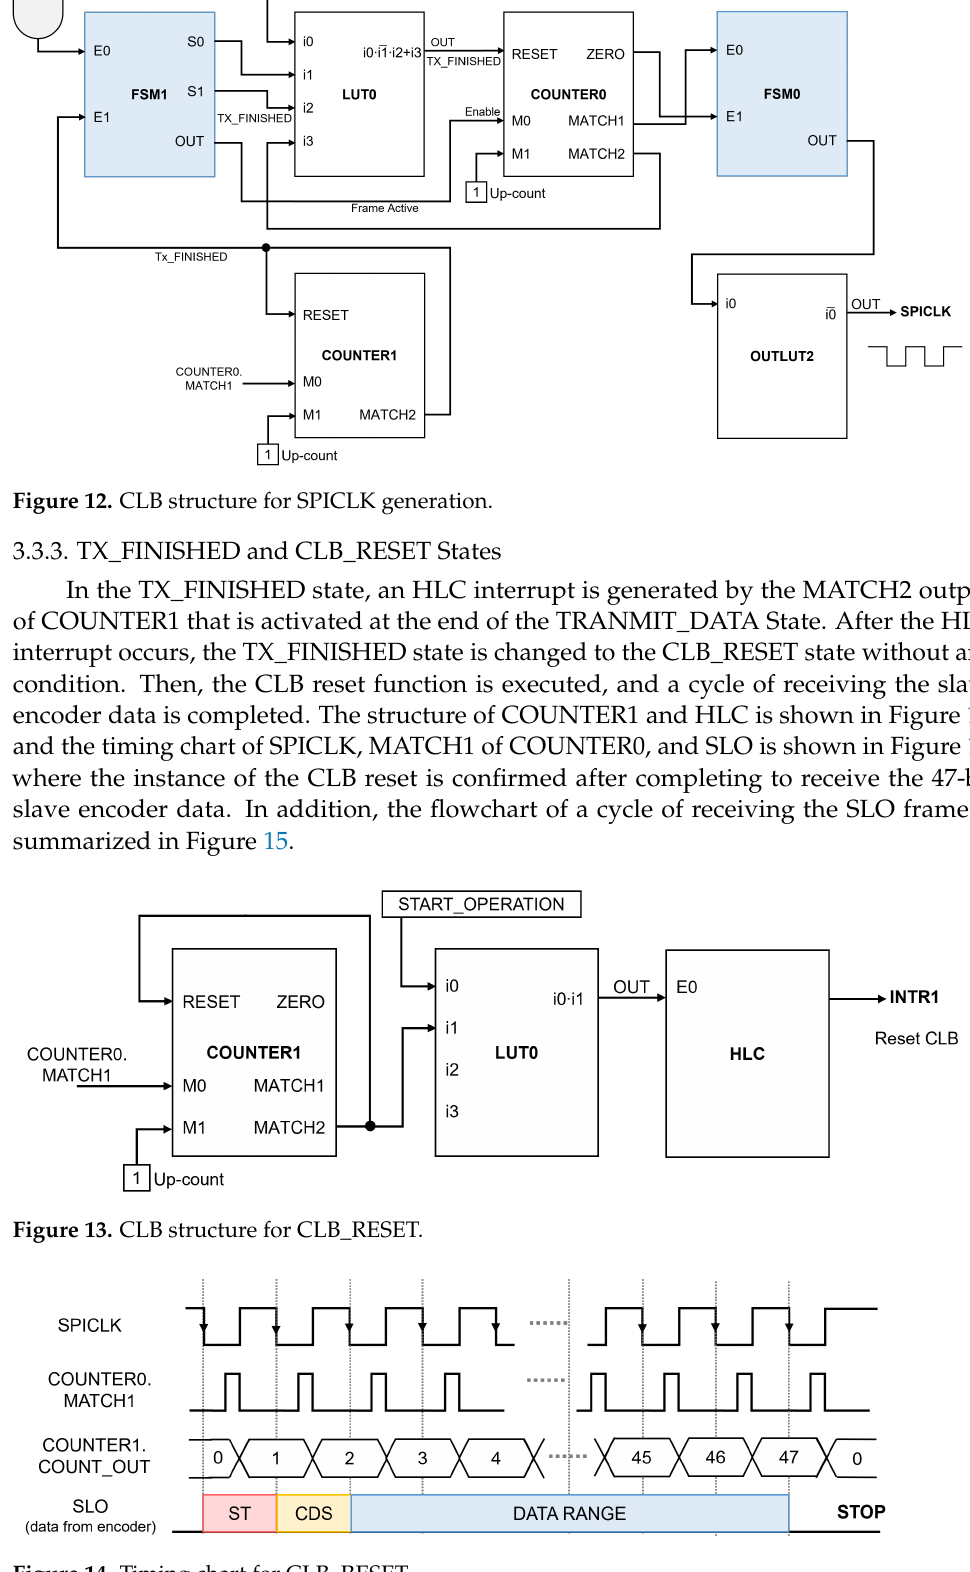
Figure 14. Timing chart for